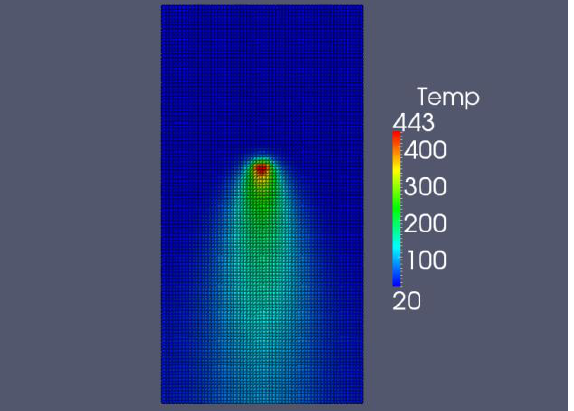
Figure 10. Temperature results from FDM simulation at optimal parameters, t = 23 s.